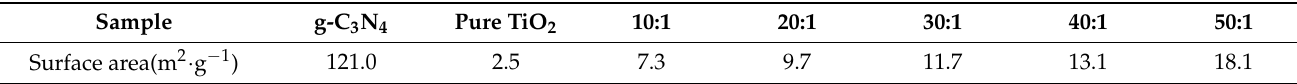
Figure 4. N 2 adsorption-desorption isotherms ( a ) and pore size distribution ( b ) of pure TiO 2 , g-C 3 N 4 and TCN-U x . Table 2. Specific surface area of pure TiO 2 and U x T 550 R 5 H 6